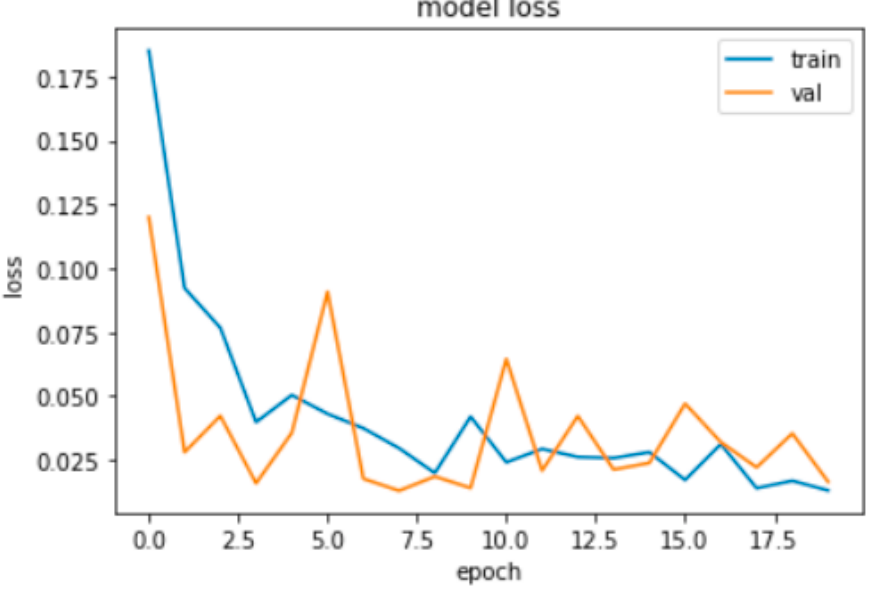
Figure 4. Training and Validation Loss of Image Classifier Model.